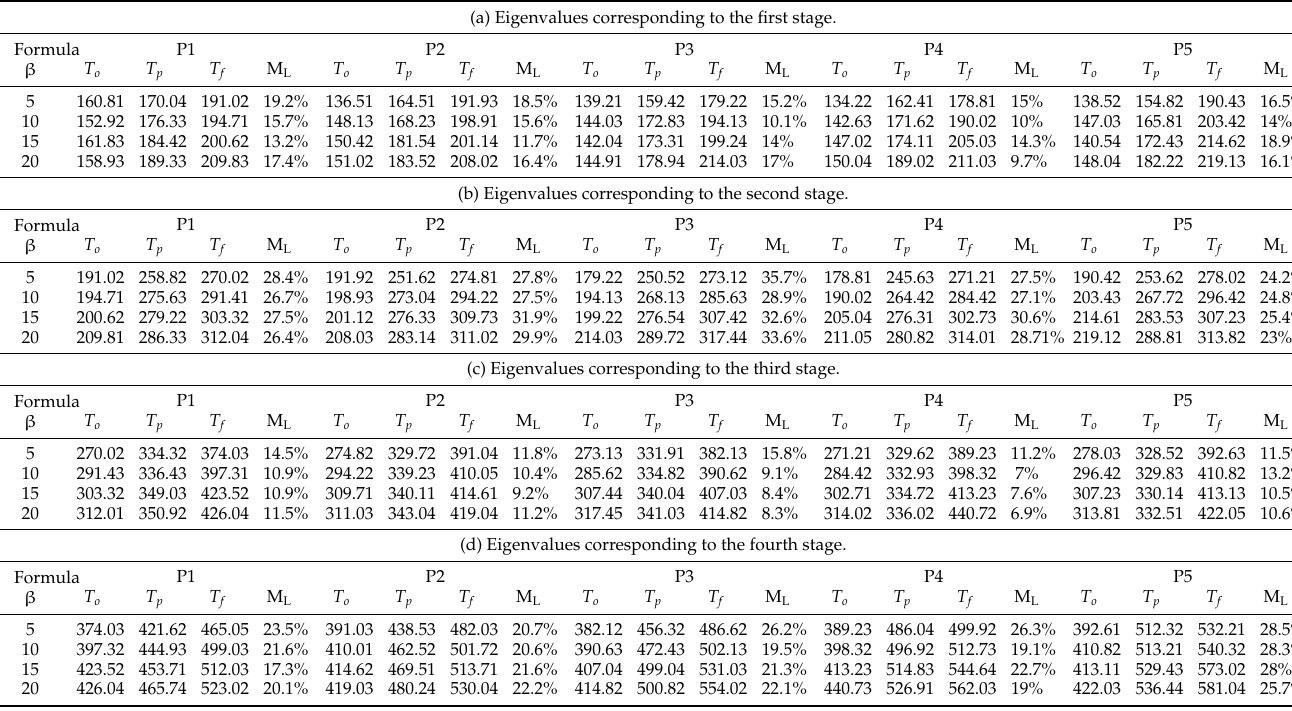
Table 6. Starting and ending temperatures and corresponding characteristic values of Samples P1–P5 at each stage, based on the DTG